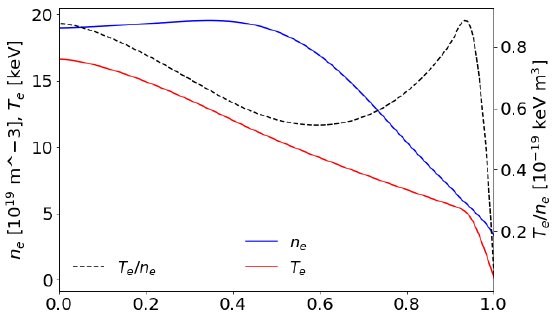
Fig. 2 : The electron temperature and density profiles for the SPR-045 plasma concept